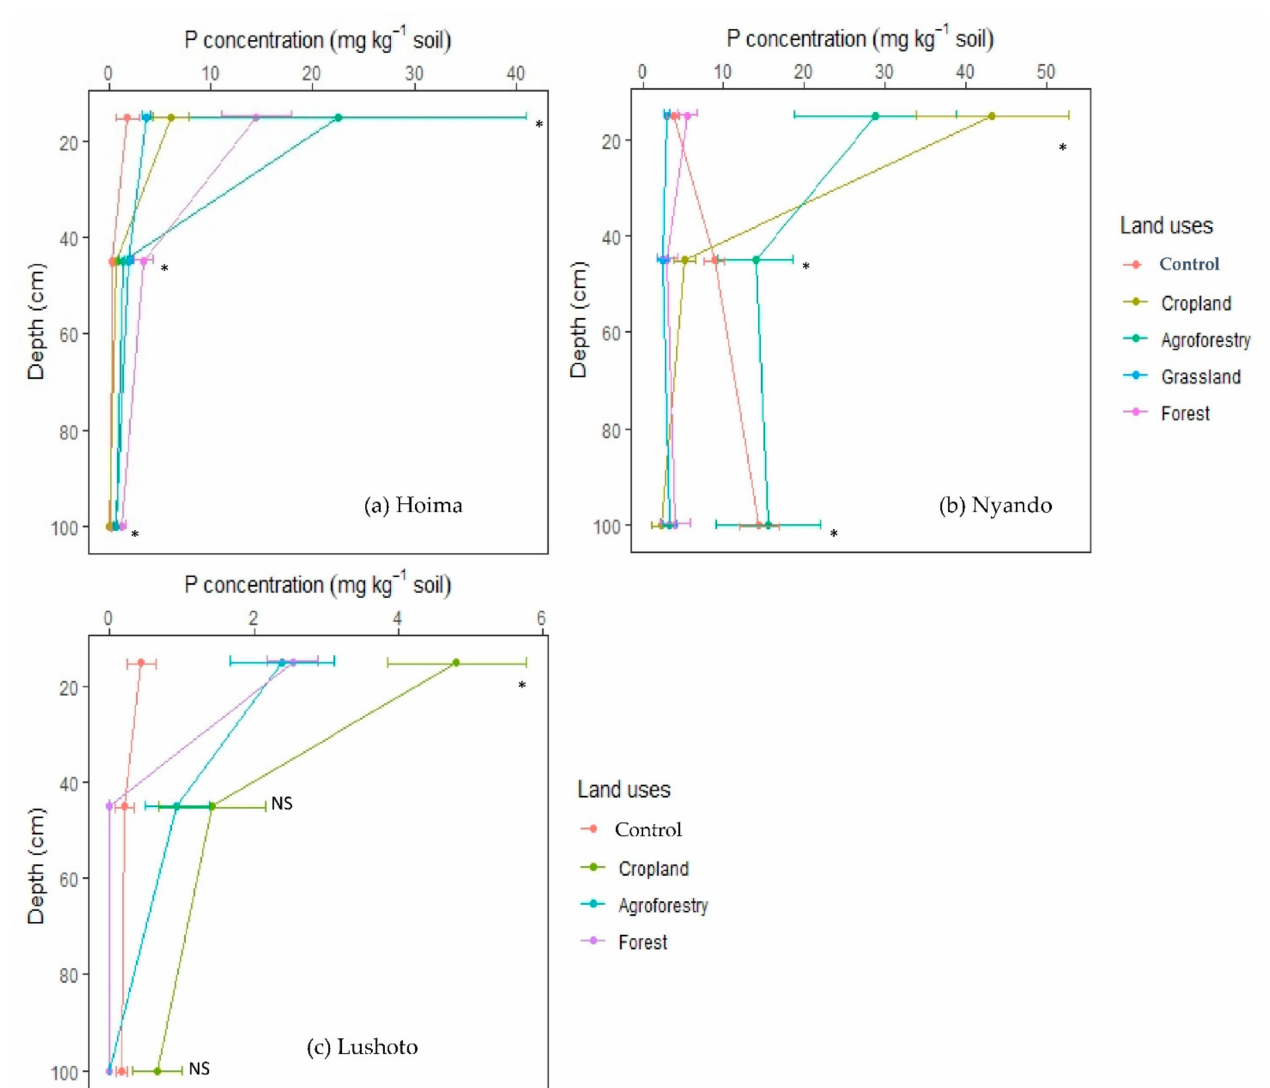
Figure 3. Phosphorus concentration in ( a ) Hoima, ( b ) Nyando and ( c ) Lushoto at different land uses: cropland, agroforestry, grassland, forest, and control at different soil depths. Error bars represent standard error of the mean. NS denotes nonsignificant differences; * denotes significant differences at p ≤ 0.05,